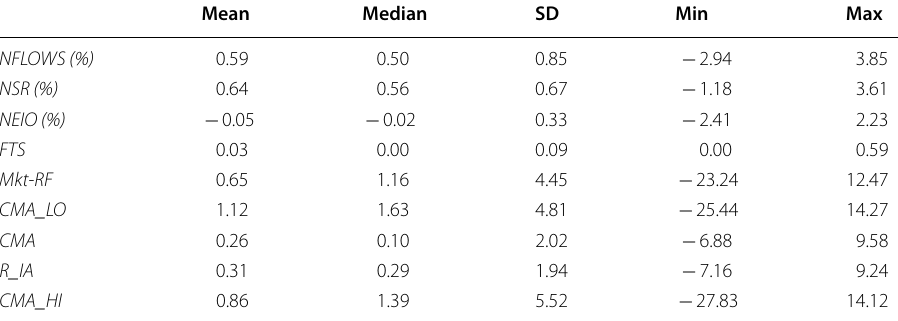
Table 1 Summary